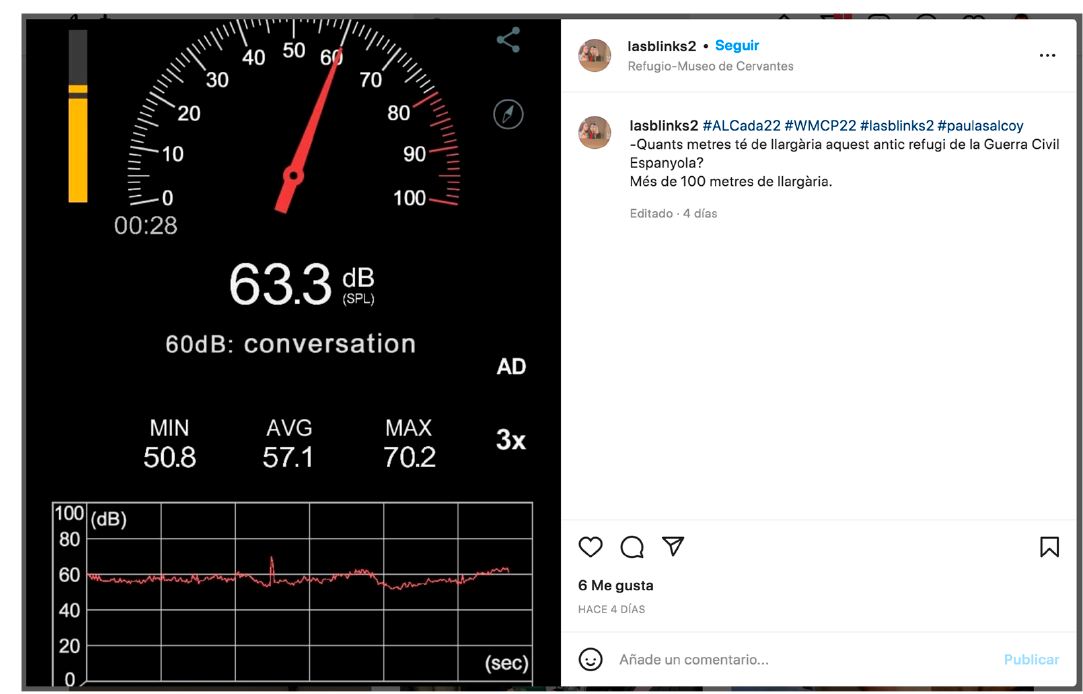
Figure A2. Example 2 of the test with the app: Sound meter. Notes: #ALCada22 #WMCP22 #lasblinks2 #paulasalcoy How many meters long is this old refuge from the Spanish Civil War? More than 100 meters in length.